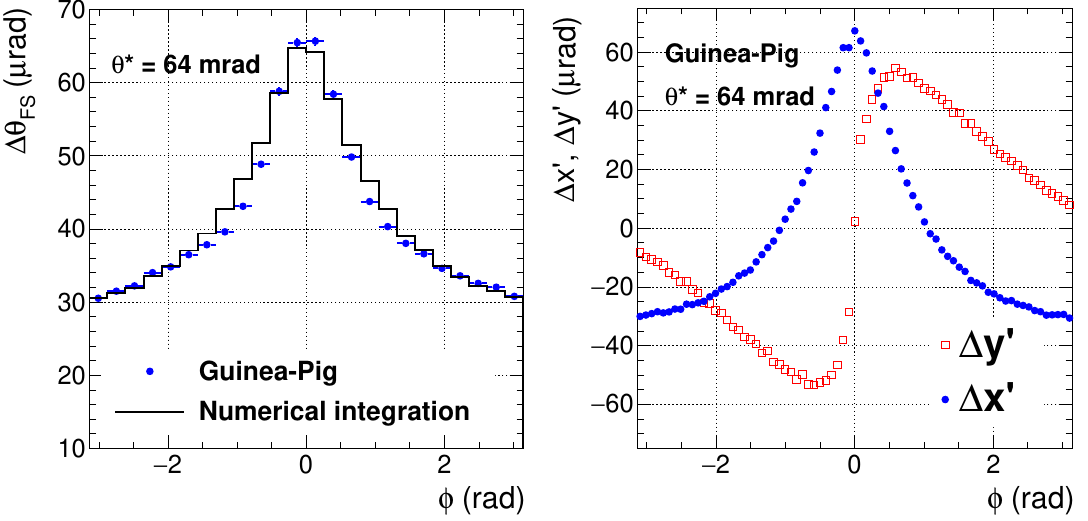
Figure 6 . Left: (cid:1) (cid:18) for 45 : 6 GeV electrons produced at (cid:18) (cid:3) = 64 mrad as a function of their FS azimuthal angle, as predicted by Guinea-Pig and by a numerical integration of the average Lorentz force felt by the electrons. Right: Angular de(cid:13)ections along the x and y directions, under the same